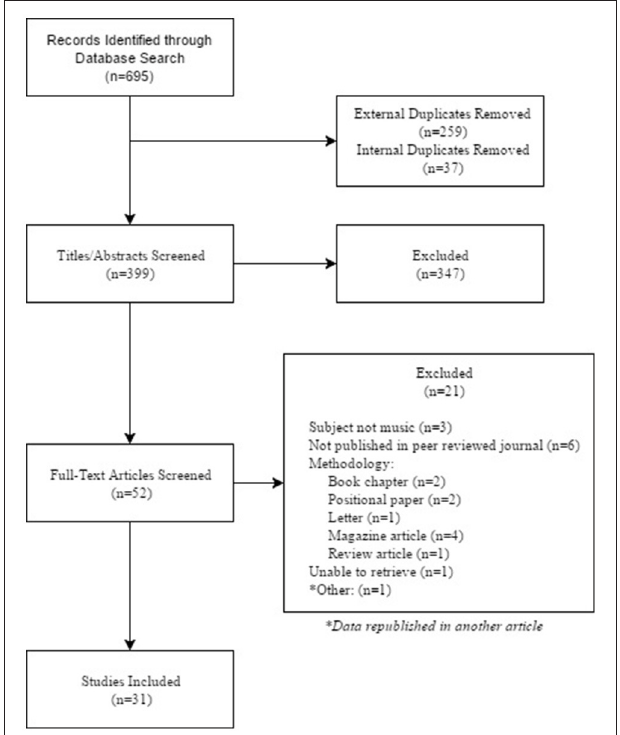
FIGURE 1 | PRISMA flow diagram.